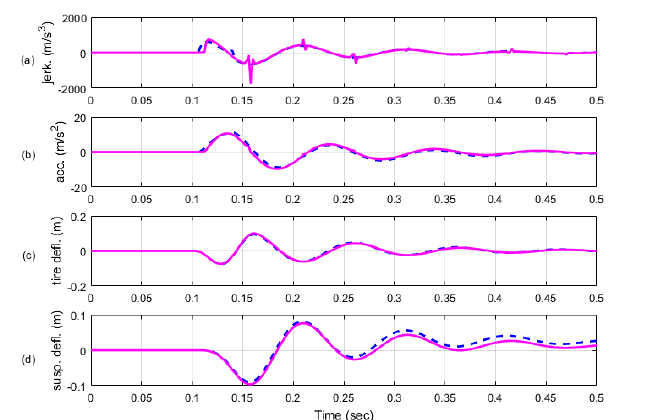
Figure 6. Road disturbance ( a ) Bump position input: ——– ; ( b ) Bump velocity input: - - - - - - .